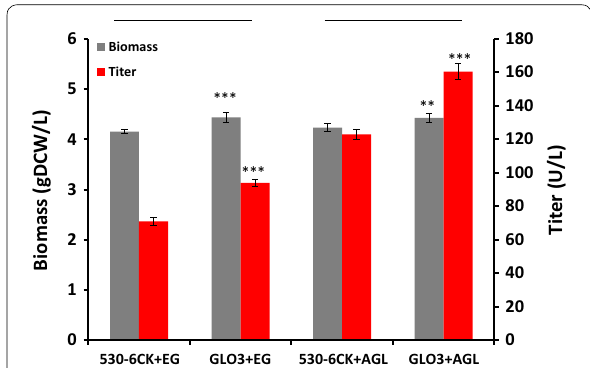
Fig. 4 Secretion of two recombinant proteins, endoglucanase and glucan 1,4-α-glucosidase, in the reference strain and GLO3 -overex- pression strain. ***P < 0.001 Measurements are reported as the aver- age value standard deviation from independent ±